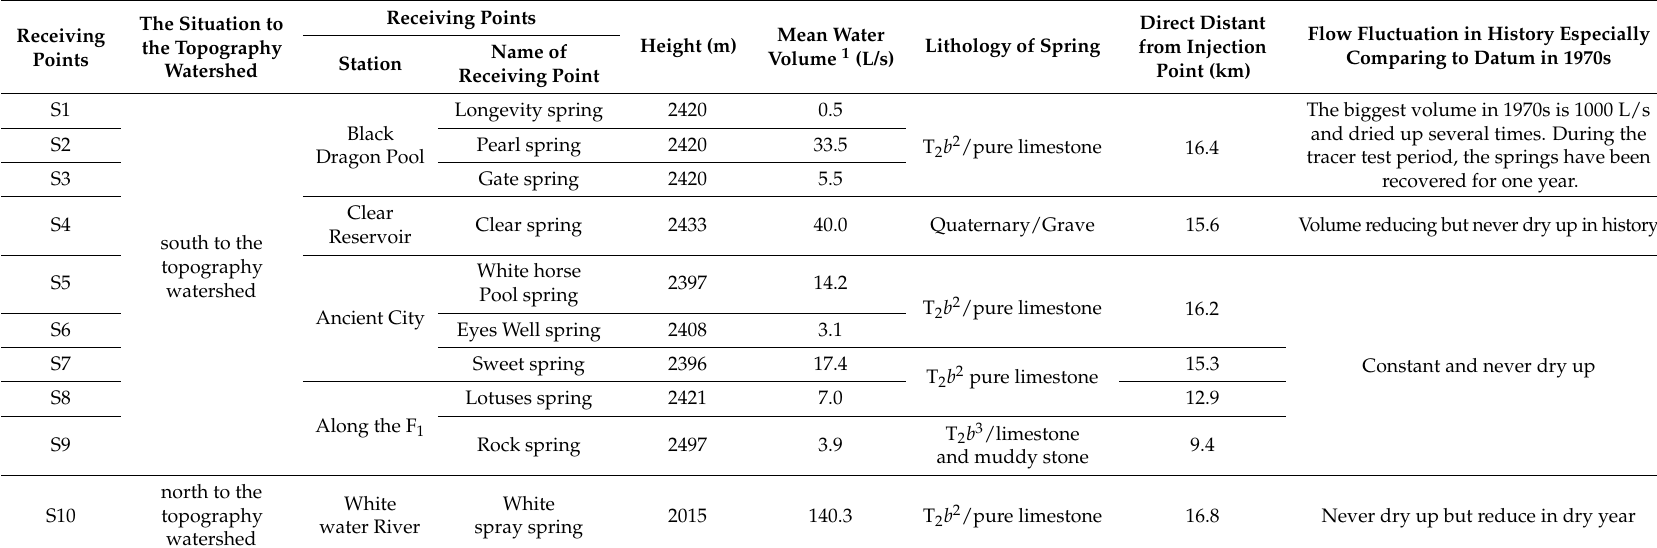
Table 1. Characterizations of every spring as receiving point.